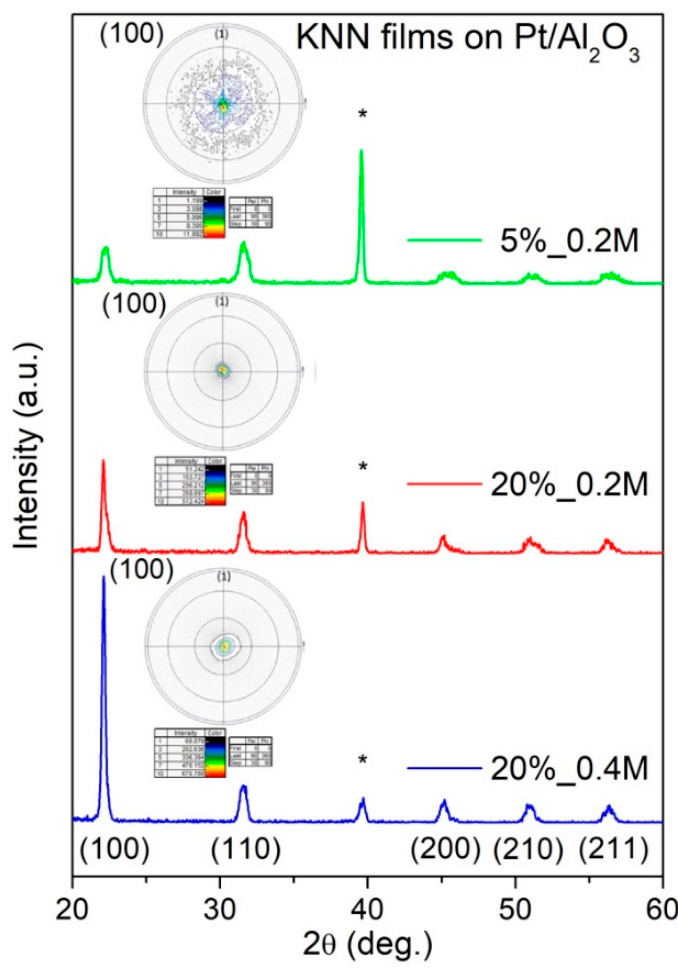
Figure 3. XRD patterns of KNN films deposited on platinized Al 2 O 3 from solutions with 5% potassium excess and 0.2 M concentration, 20% alkali excess and 0.2 M concentration, and 20% alkali excess and 0.4 M concentration. Substrate peaks are marked by *. Insets show corresponding pole figures of the films measured for the (100) plane.